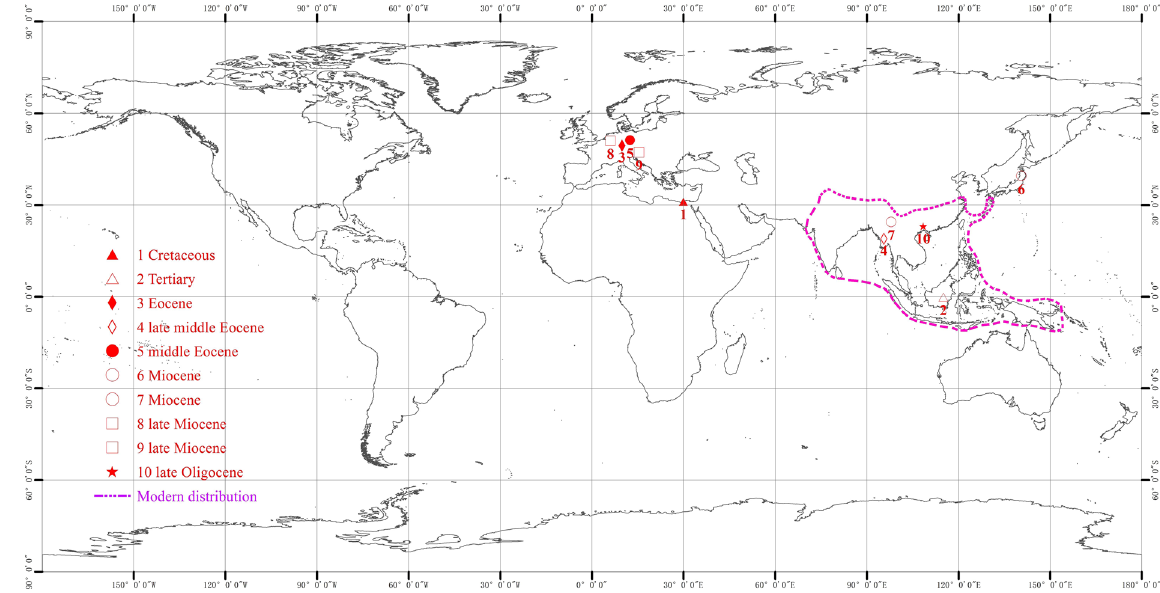
Figure 7. Map showing modern and fossil distribution of Schima and related fossil taxa, generated by X. G. Shi, using Arcgis 9.3 (ESRI, Redlands, CA,